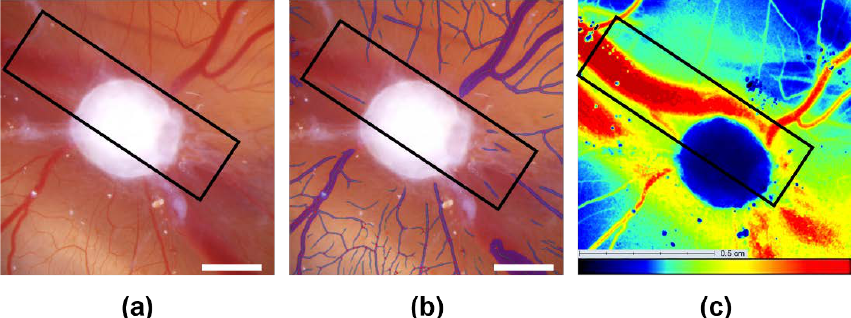
Figure 5. Location-dependent recognition of blood vessels by the CAM Assay application and LSCI (the white bar indicates 2 mm). ( a ) Original microscopic image. ( b ) Analysis using the CAM assay application v3.0.0. The vessels marked in purple were recognized by the application. The deep vessel which is marked by a black rectangle is not recognized by the CAM assay application. ( c ) Perfusion image of the same CAM with an AS-M cell line tumor in the center. The same vessel marked by the black rectangle is clearly included in the LSCI-based measurement.